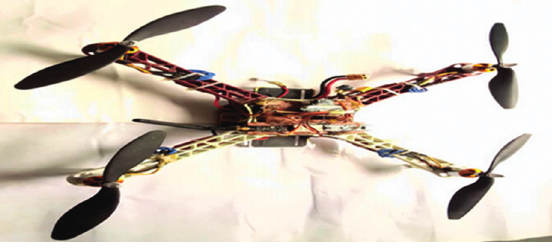
Figure 9: The developed UAV. Table 2: Result from the modules.